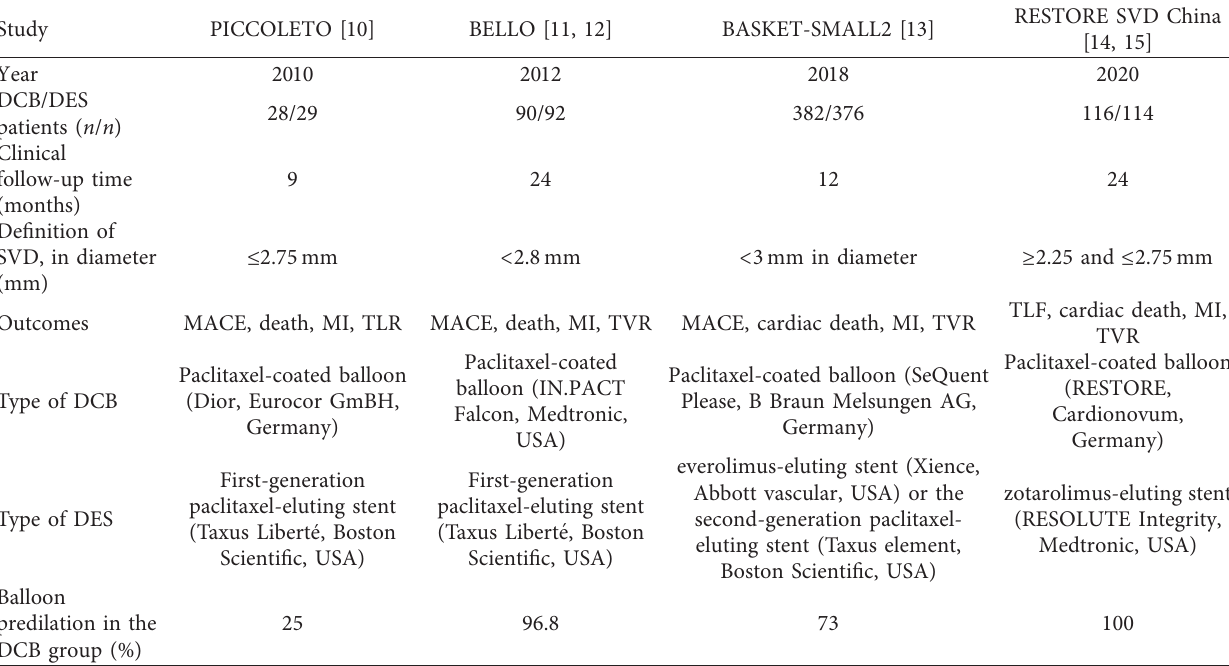
Table 1: Main characteristics of included